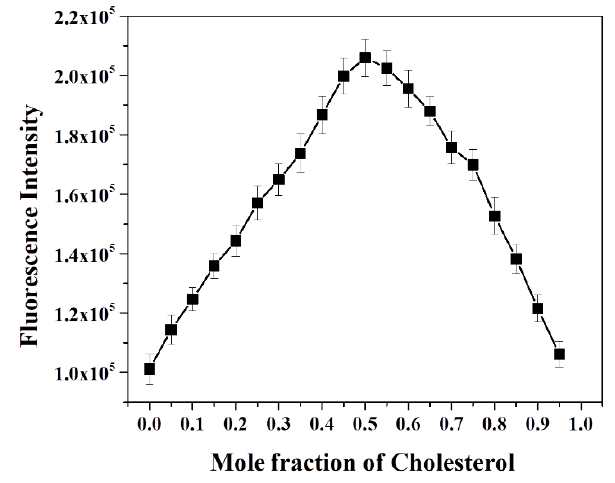
Figure 5. Assessment of the host-guest complexation stoichiometry between cholesterol and OFP-CD. Evolution of the fluorescence intensity of aqueous mixtures of OFP-CD pre-quenched with dabsyl chloride in the presence of increasing mole fractions of cholesterol ([OFP-CD+Q] = 100 µM; [cholesterol] = 100 µM).